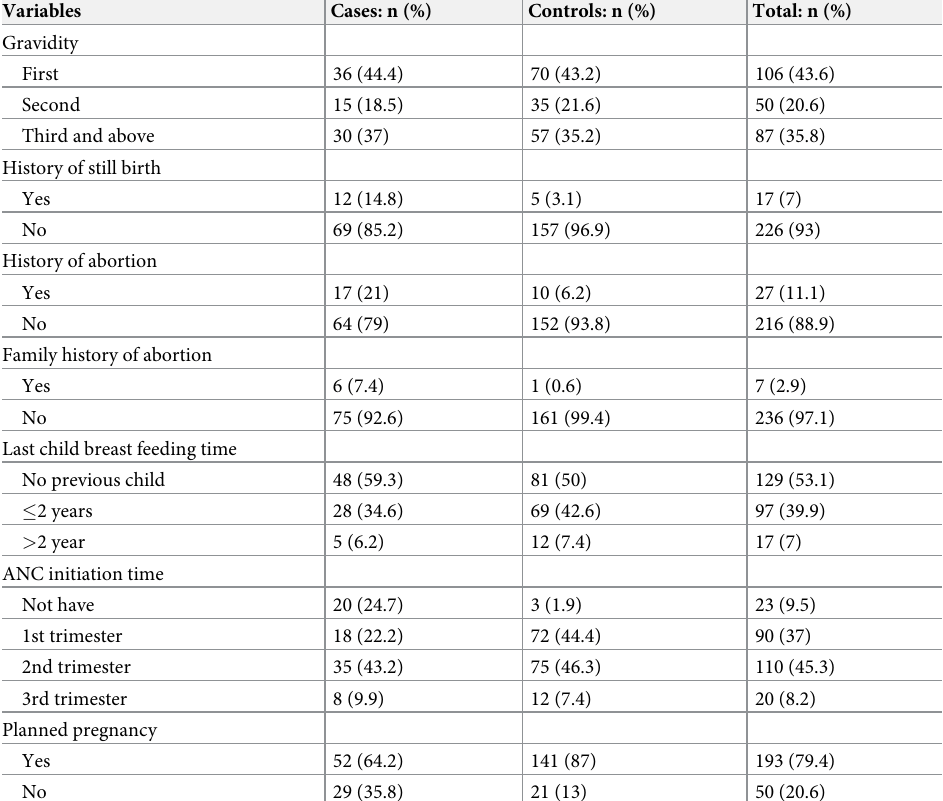
Table 2. Reproductive history of mothers who gave birth in North Shoa Zone Hospitals, Amhara Region, Ethio- pia,